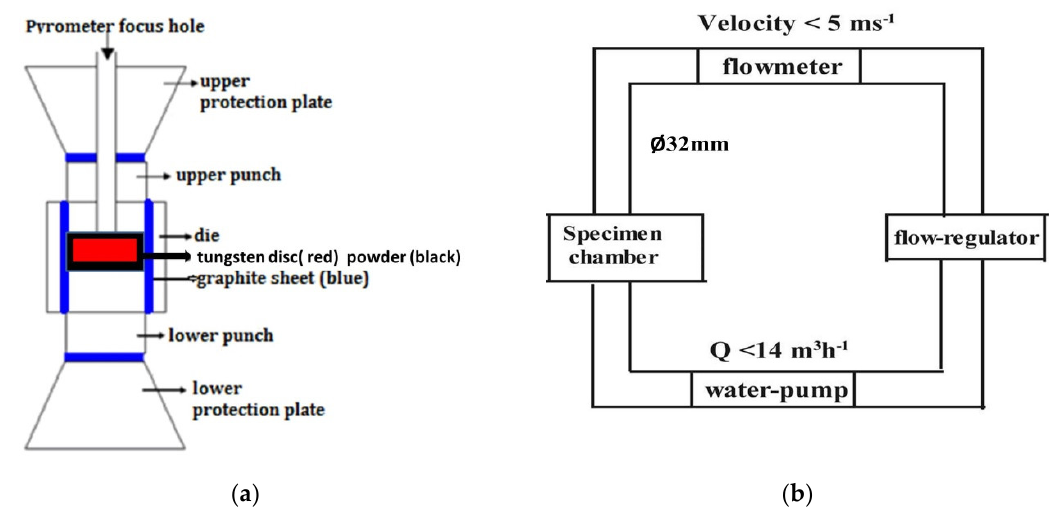
Figure 1. The schematic diagram of the sample placement in the spark plasma sintering setup ( a ) and the self-designed water flowing device ( b ).